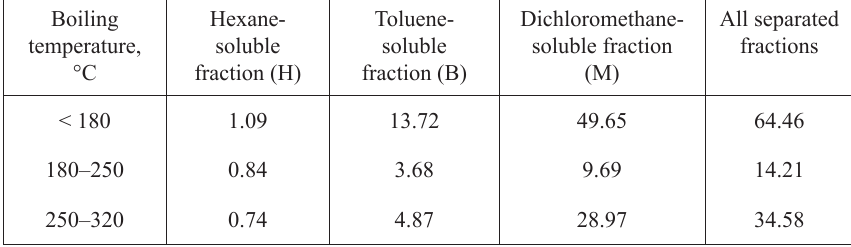
Table 5. The results of SCG of distillation fractions Boiling